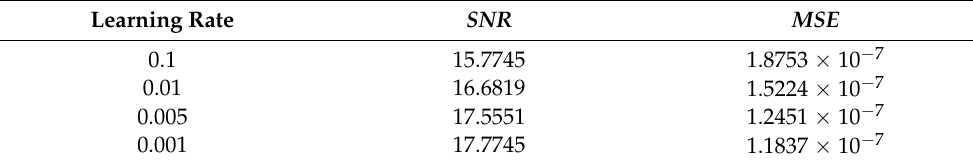
Table 3. The comparison experiment of the learning